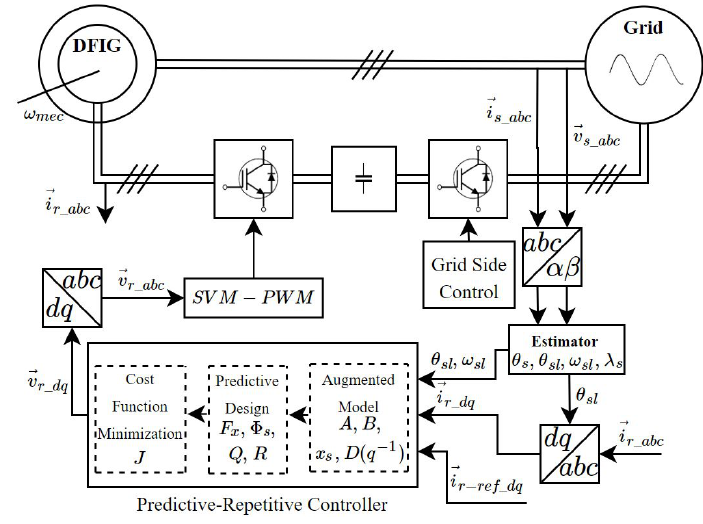
Figure 1. Current control scheme using predictive-repetitive controller.